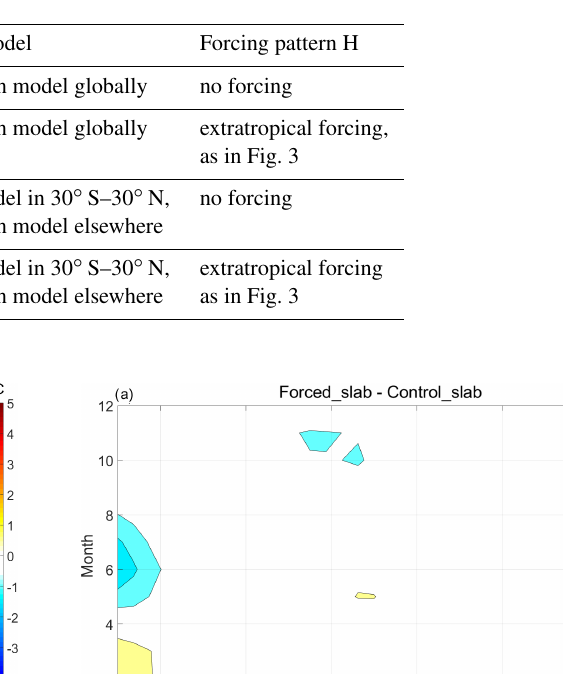
Table 1. Experiment summary.